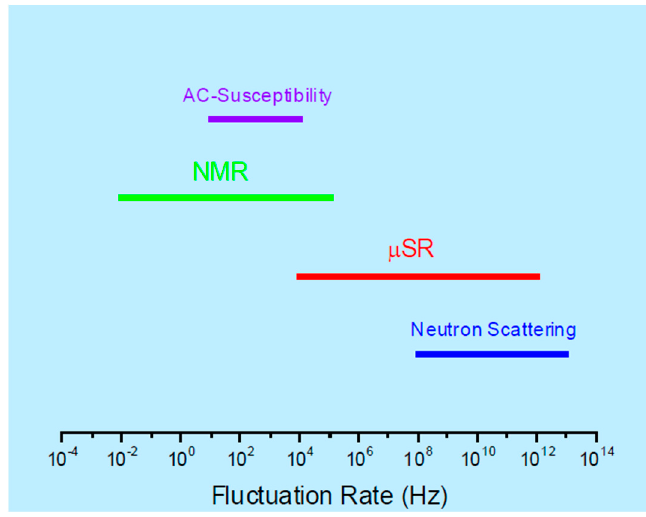
Figure 7. Time windows for several experimental probes on magnetism.